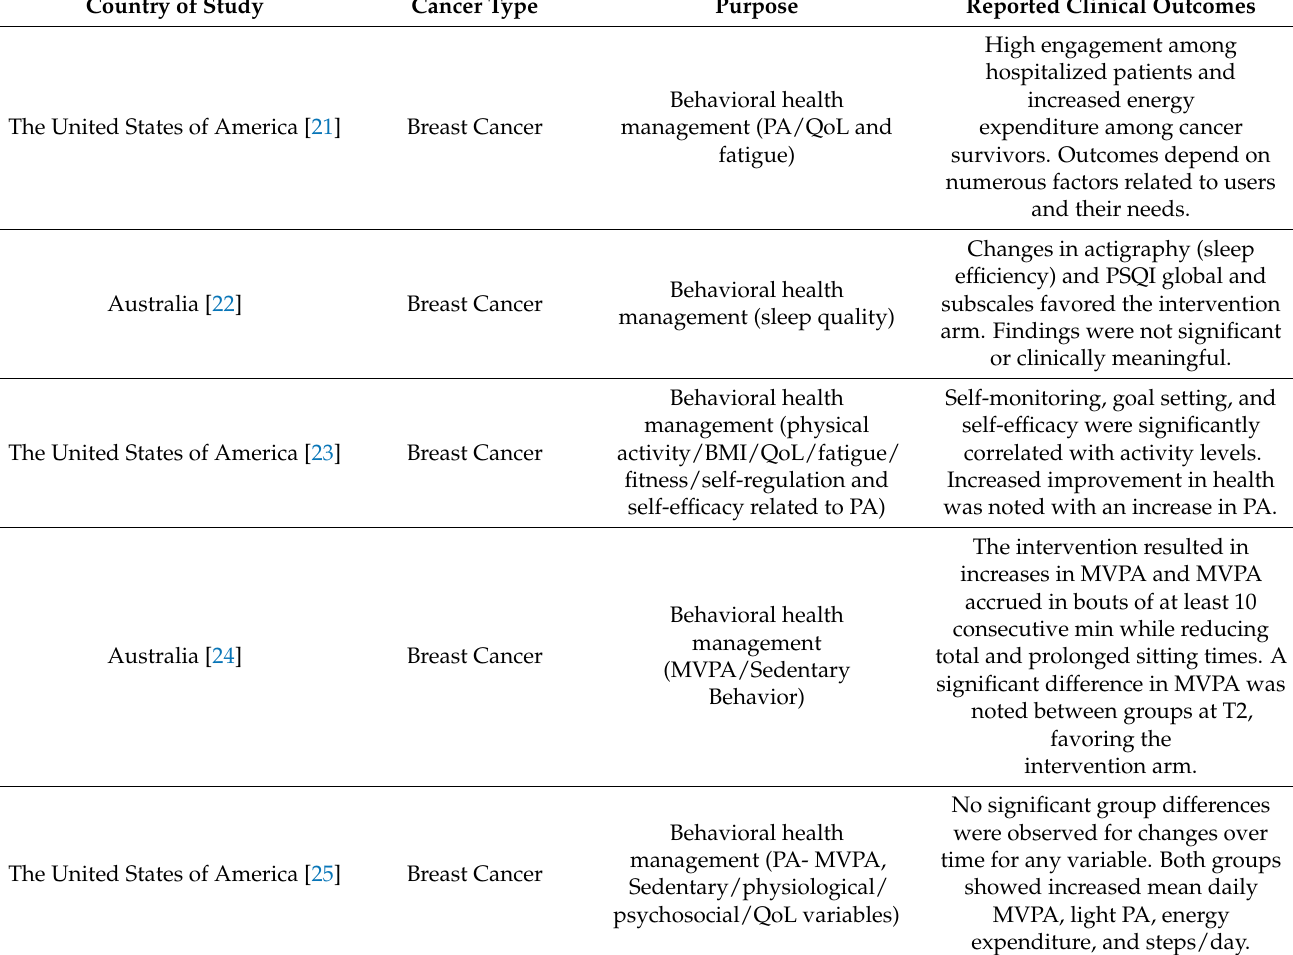
Table 3. Reported clinical outcomes in the cancer population using wearable